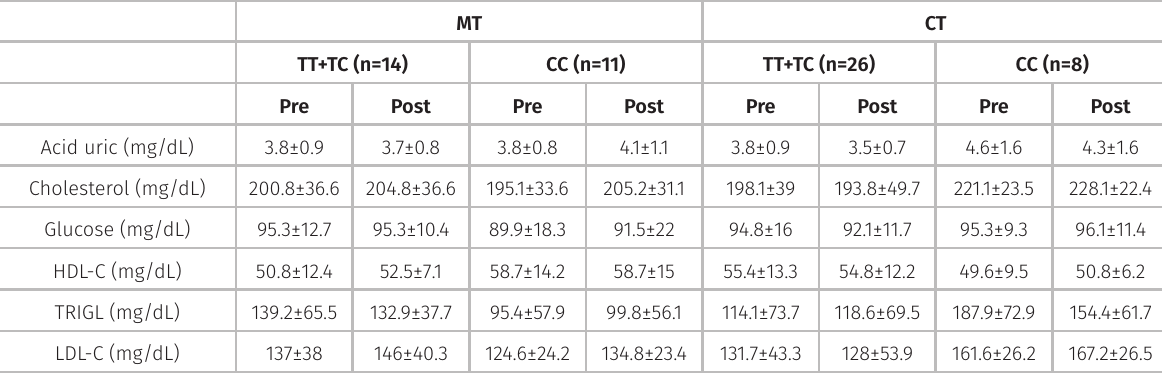
Table VIII. Blood analyses of MT and CT groups related to ACTN3